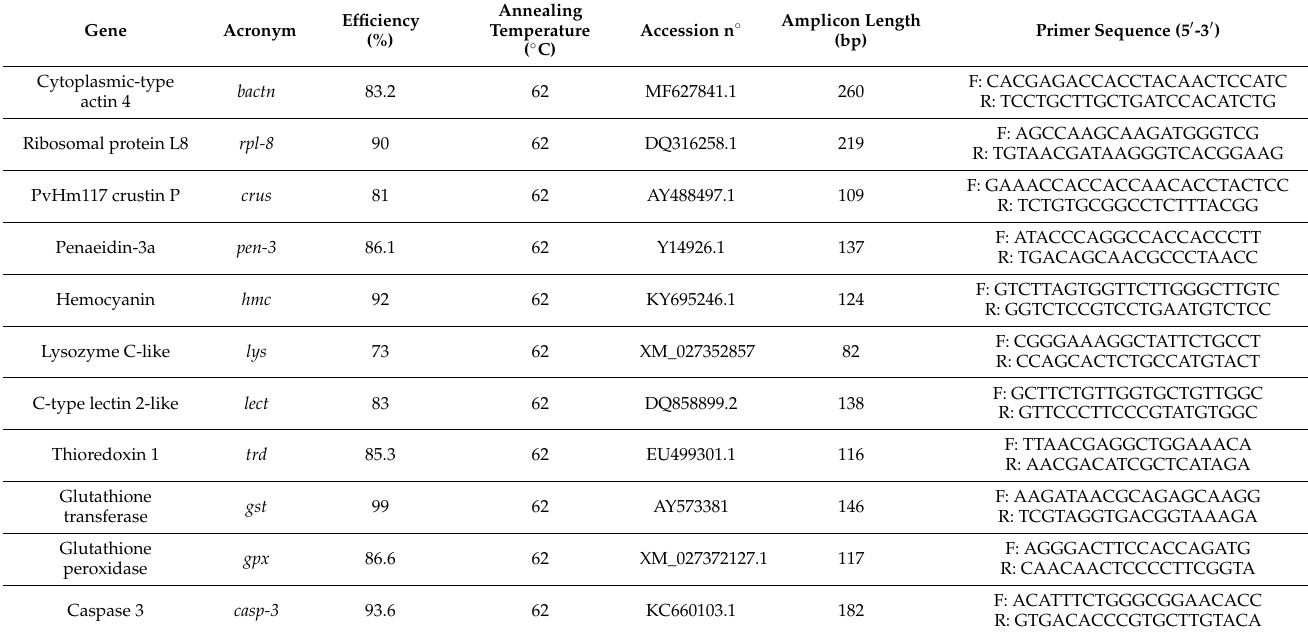
Table 3. Selected genes and specific primers used to evaluate the immune status of whiteleg shrimp ( P. vannamei ) PL at the end of the experimental